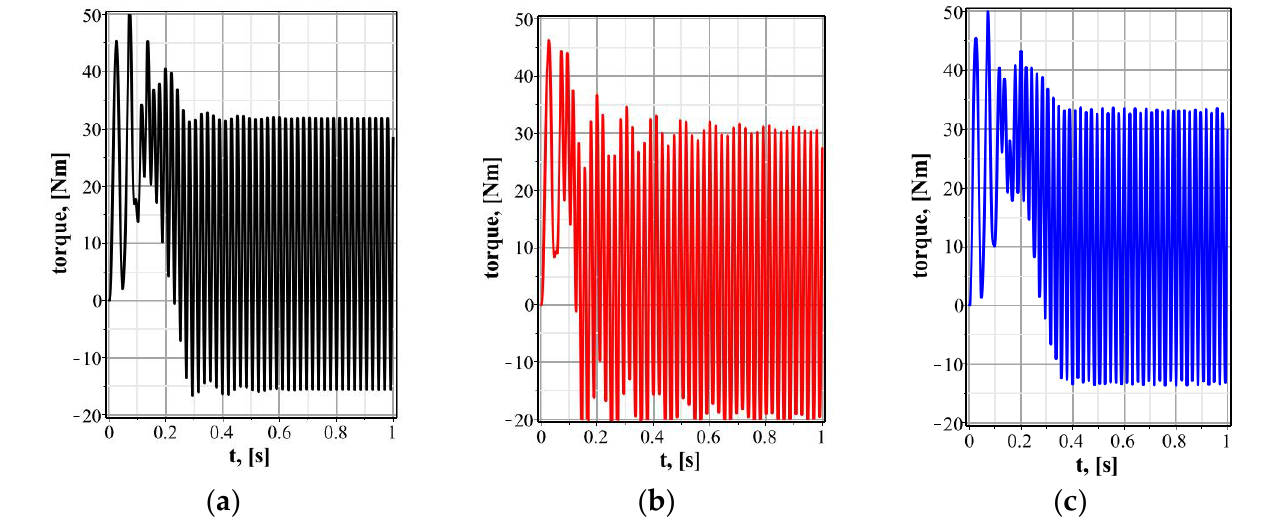
Figure 5. Time dependence of the electric motor’s shaft torque at different synchronization conditions of the unbalanced rotors. ( a ) 𝜔 2 = 𝜔 1 ; ( b ) 𝜔 2 = −𝜔 1 ; ( c ) 𝜔 2 = 2𝜔 1 .